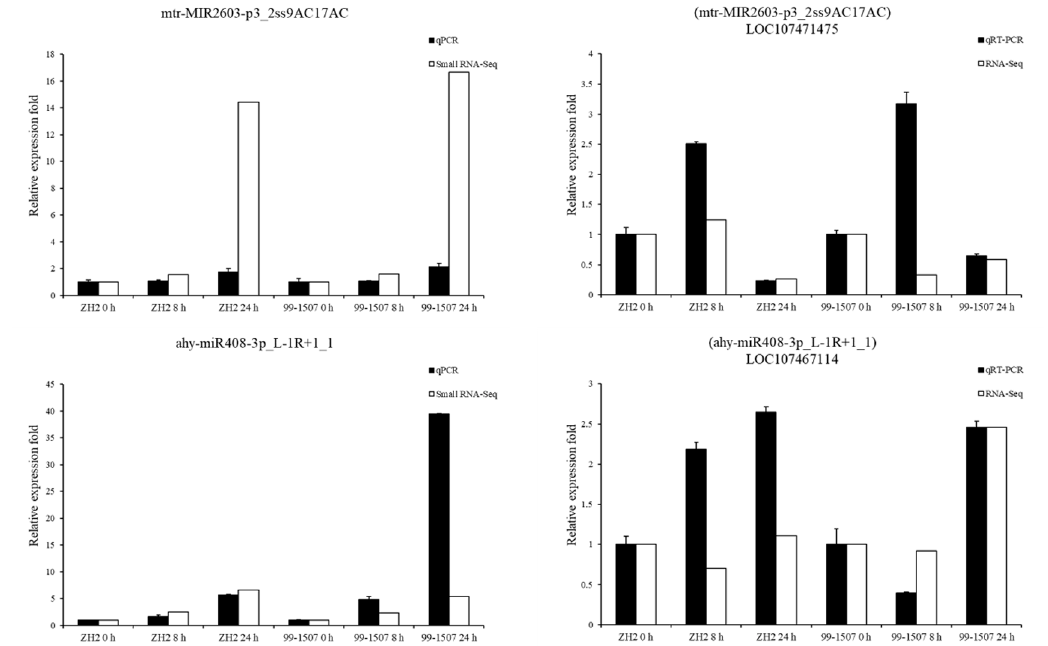
Figure 7. Relative expression results of miRNAs and their targets via qRT-PCR. U6 and actin were used as the internal references for miRNAs and mRNAs, respectively. The normalized miRNA levels and the FPKM values represent the expression level in RNA-seq of each sample, respectively. The expression level at 0 h in each sample was used as a reference state, which was set to 1, and fold change values were shown here.